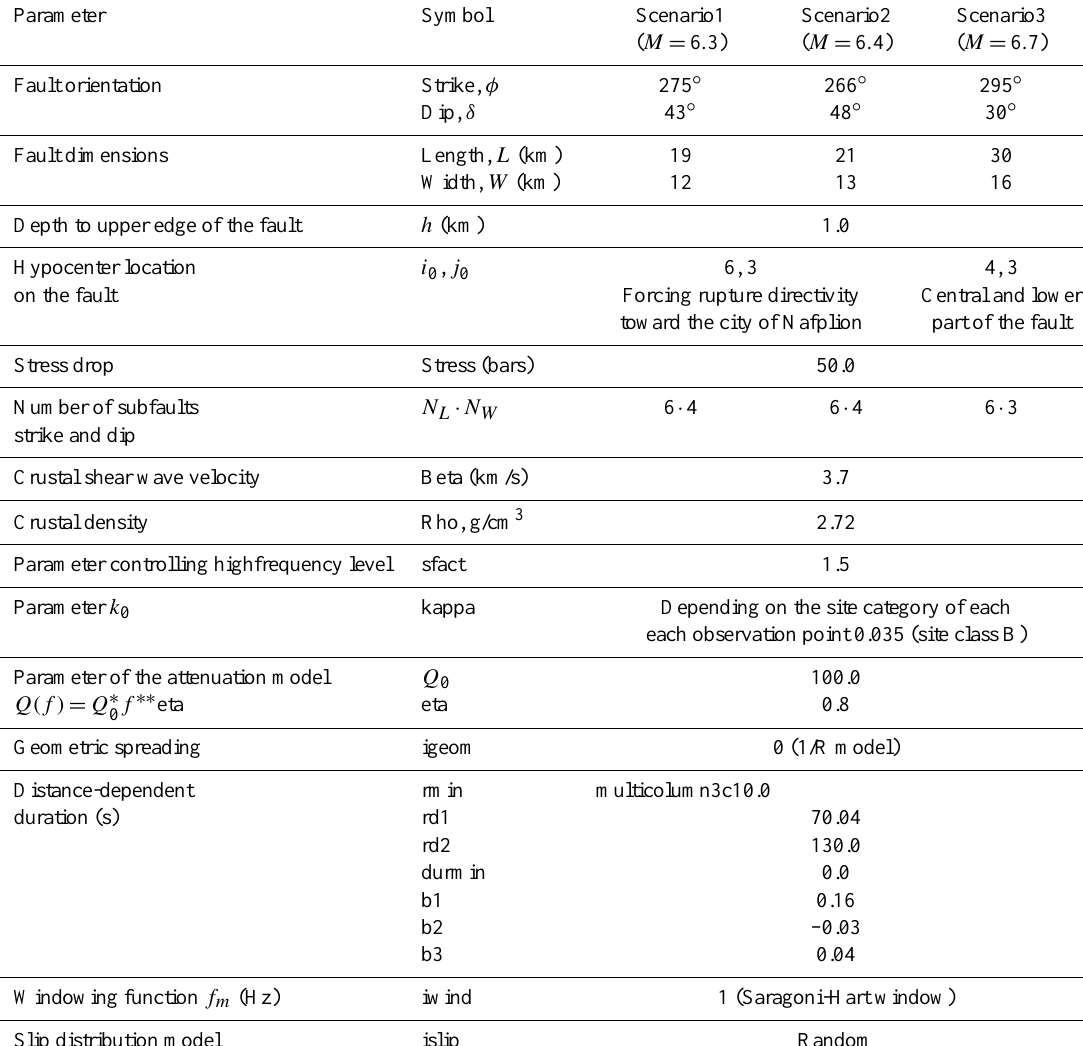
Table 1. Parameters adopted in the stochastic simulation of strong ground motion from three scenario earthquakes in the broader area of Nafplion city (see text for further information on the selected scenario